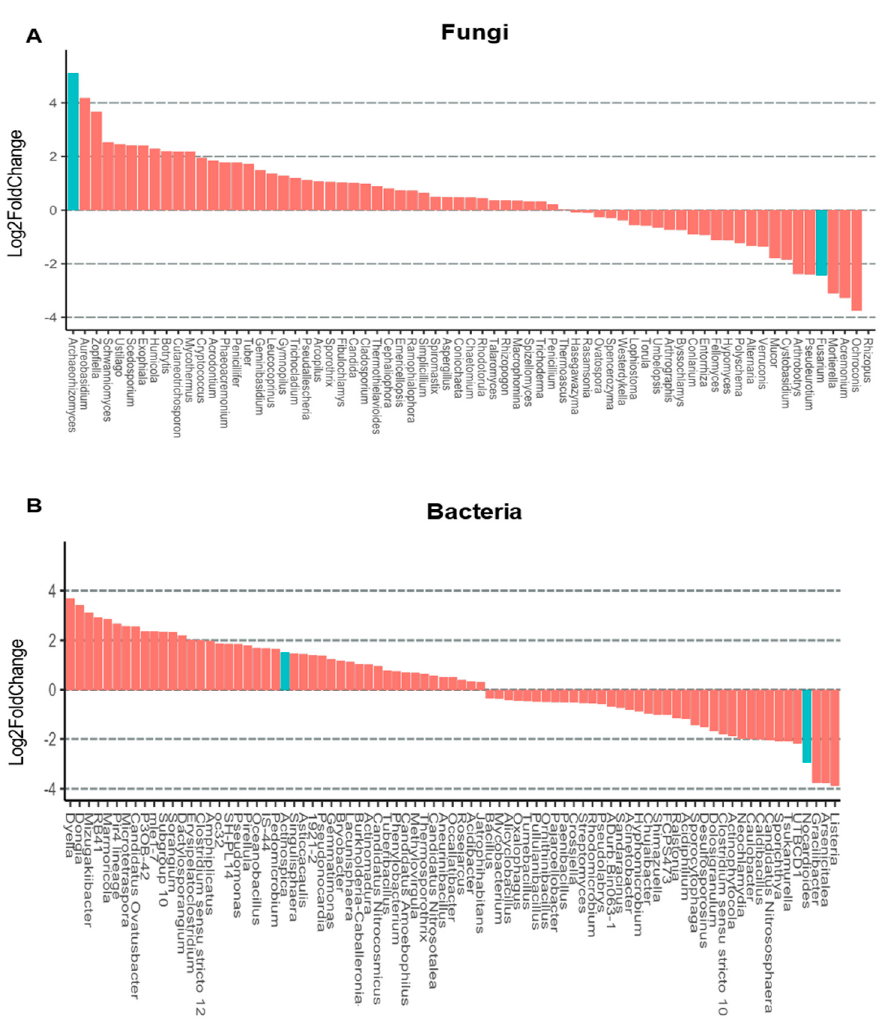
Figure 4. Changes in the relative abundance of the genera as a function of plant condition for fungi ( A ) and bacteria ( B ). The Y -axis represents the log2 of fold change. Red bars indicate p -value ≥ 0.05 and blue bars indicate p -value < 0.05. Only genera whose p -values were below 0.6 are depicted.